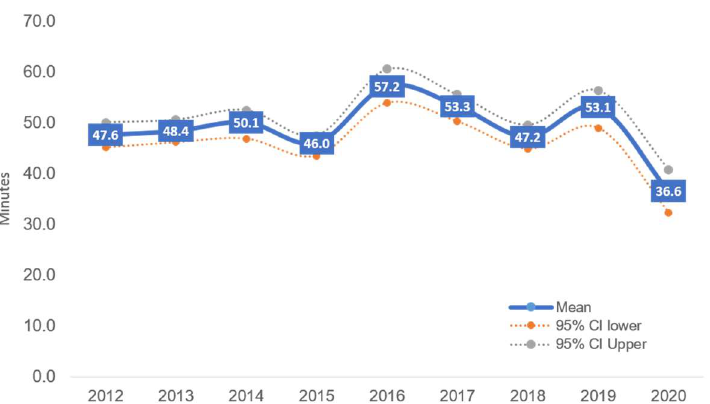
Figure 2. Average daily MPA (in minutes) among Thai children aged 6–17 years. Boys were consistently more active than girls in all nine rounds of the SPA. Although the pattern is inconclusive, the proportion of boys who met the recommended level of 60 min of daily MVPA increased in the most recent rounds (SPA2018–2019), but there was a sharp decline in SPA2020 during the spread of COVID-19. The proportion of girls with adequate MVPA ranged between 13.4 percent (SPA2020) and 23.4 percent (SPA2012) (Table 2).